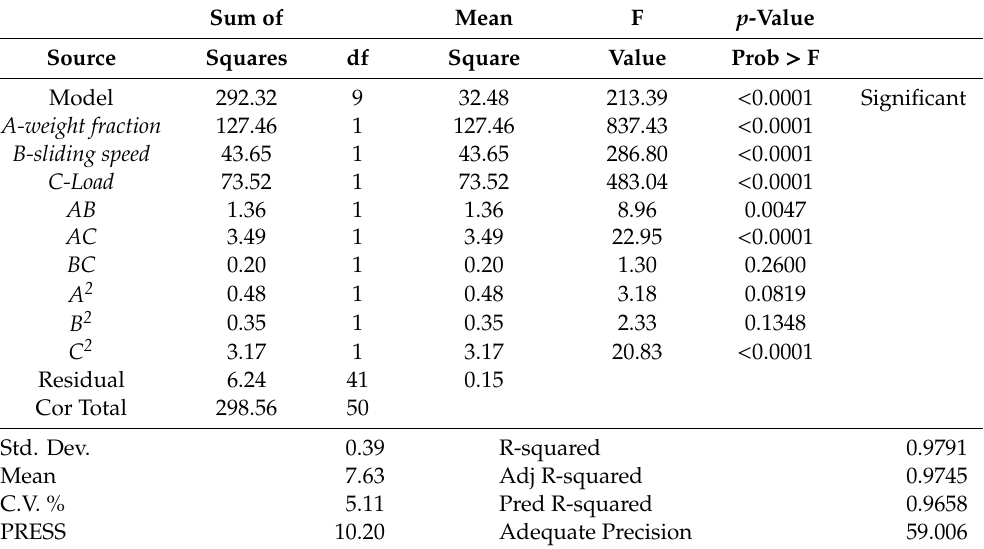
Table 7. ANOVA results for the quadratic model of wear